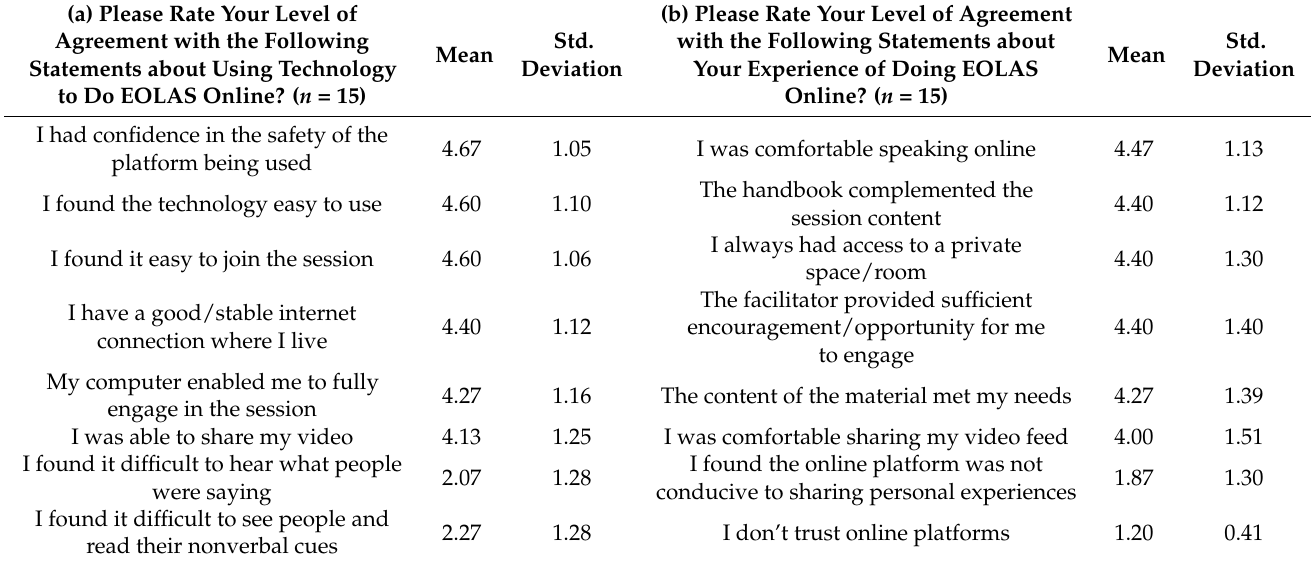
Table 4. Attendees’ experiences of ( a ) using technology, ( b ) doing